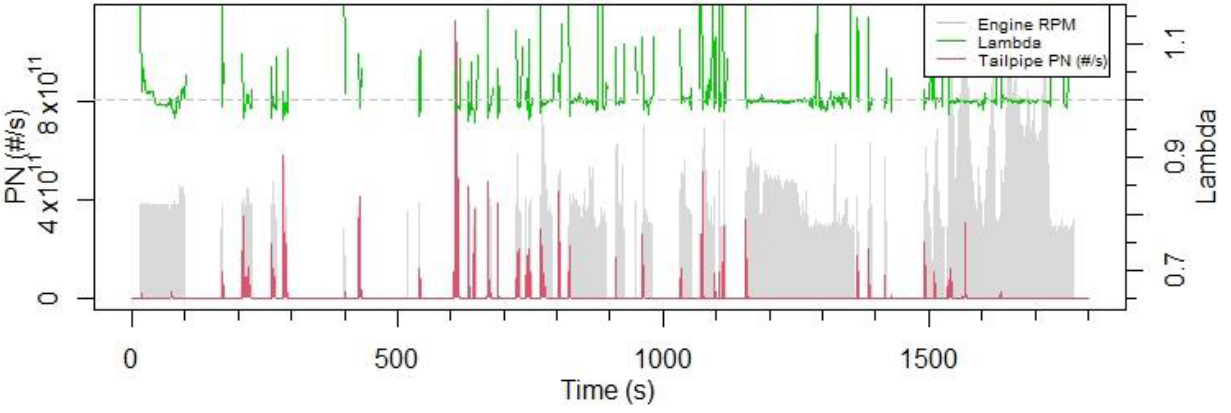
Figure 14. Total HEV PN emission rate alongside engine RPM and lambda (the actual air–fuel ratio divided by the stoichiometric air–fuel ratio).